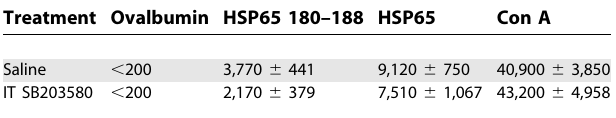
Table 2. Effect of IT p38 Inhibitor on T Cell Proliferation in